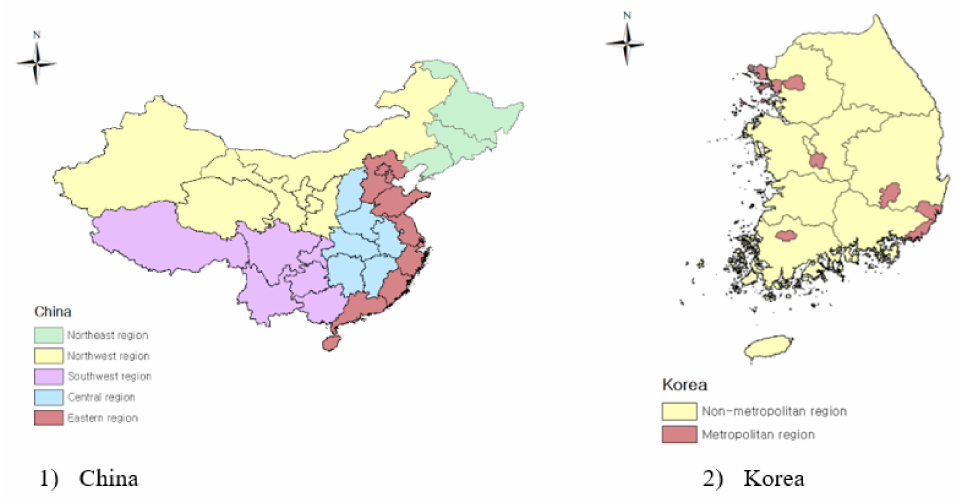
Figure 1. Regional Division of Two